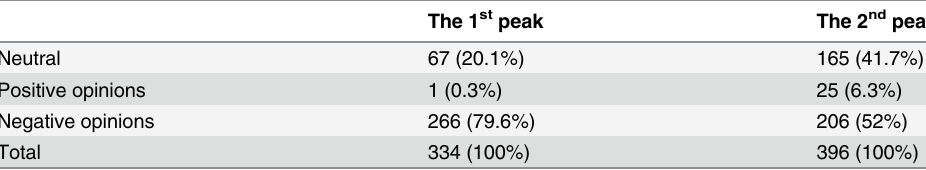
Table 2. Qualitative analysis results of